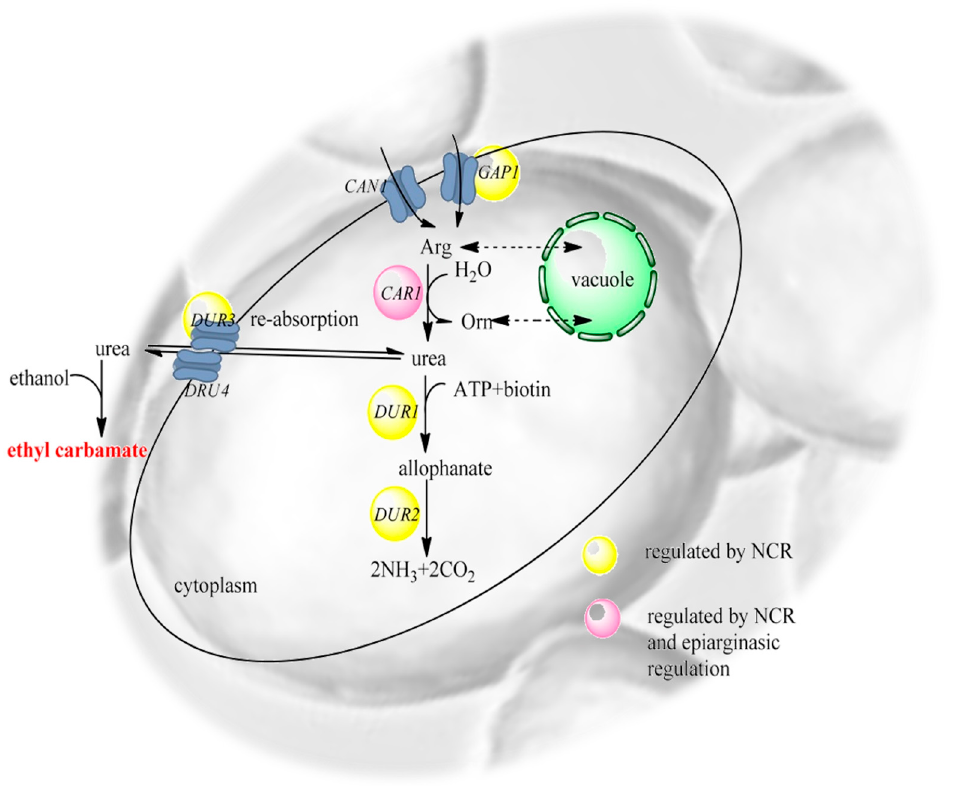
Figure 4. Schematic metabolism of urea and arginine by S. cerevisiae . Intracellular urea mainly results from the degradation of arginine through catalysis by arginase (CAR1). As a toxic and poor nitrogen source for S. cerevisiae , the generated urea is usually accumulated and exported to the surrounding medium via a facilitated di ff usion system. NCR—nitrogen catabolic repression; ATP—adenosine triphosphate; CAN1—arginine transporter; GAP1—general amino acid permease [74].